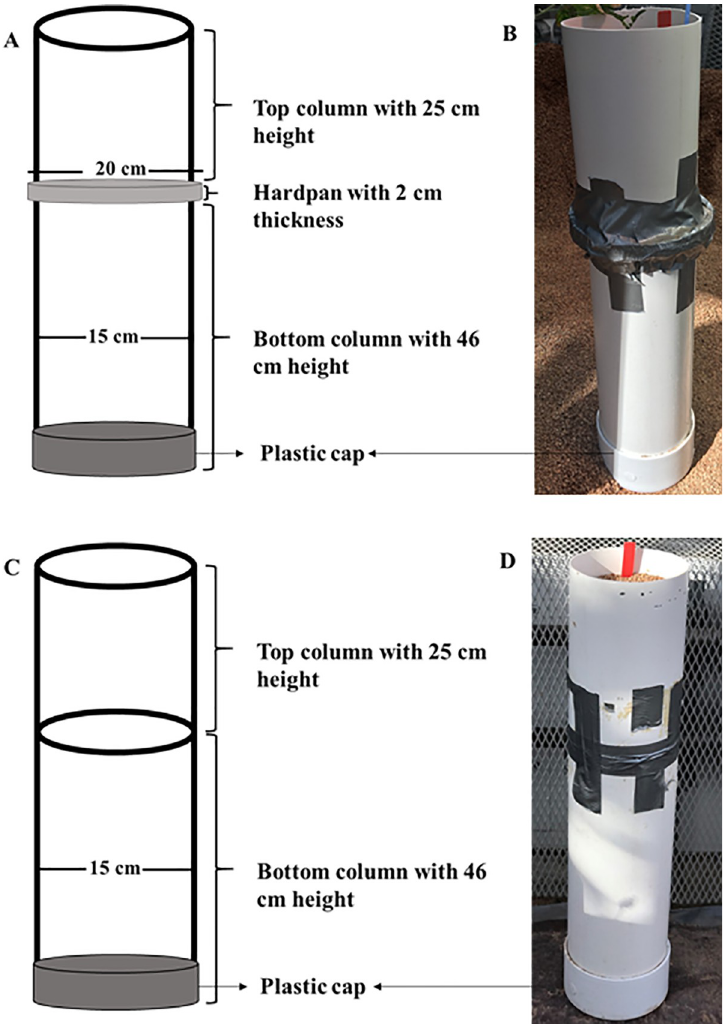
Fig 1. The mesocosms used to grow soybean plants in the experiment. Mesocosms were constructed of two stacked polyvinyl chloride (PVC) columns with an inside diameter of 15 cm. The height of the bottom and top columns were 46 and 25 cm, respectively. Each mesocosm was sealed at the bottom with a plastic cap, which had a central hole of 0.5 cm diameter for drainage. A diagram and a photograph of a mesocosm that contained a synthetic hardpan in between the top and bottom columns (A and B, respectively). The synthetic hardpan was made up of paraffin wax and petroleum jelly, and had a diameter of 20 cm and thickness of 2 cm. A diagram and a photograph of a mesocosm that did not contain a synthetic hardpan (C and D, respectively). The top and bottom columns along with the synthetic hardpan in between (if the mesocosm contained one) were tightly sealed together with a duct tape as shown in Fig 1B and